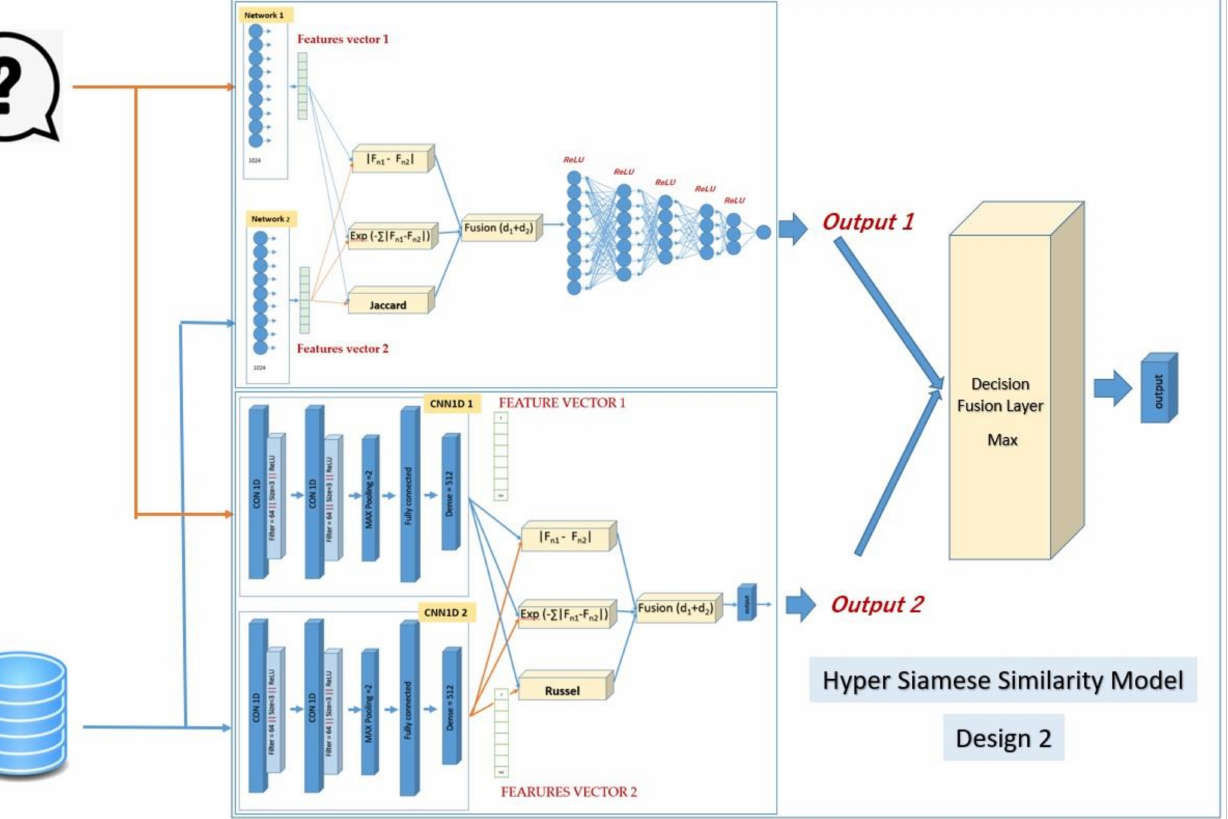
Figure 3. The design of the hybrid Siamese similarity model with three similarity measures using decision